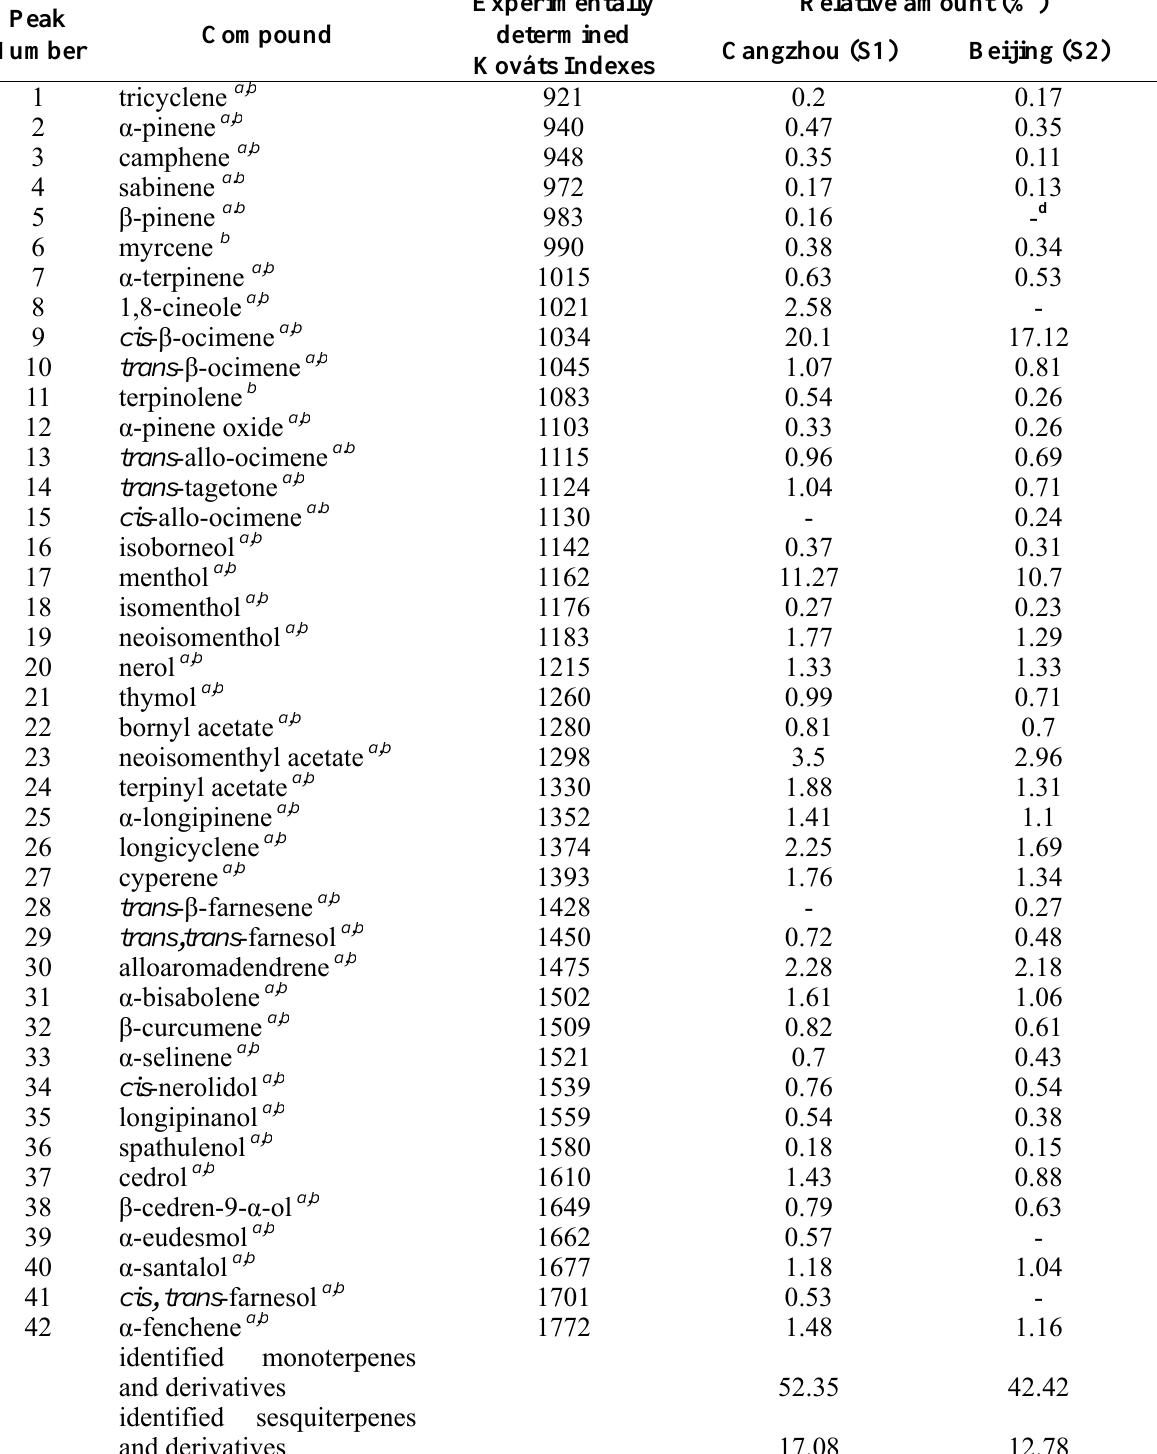
Table 1. Chemical composition of two samples of Descurainia sophia (Flixweed) and their corresponding retention indices